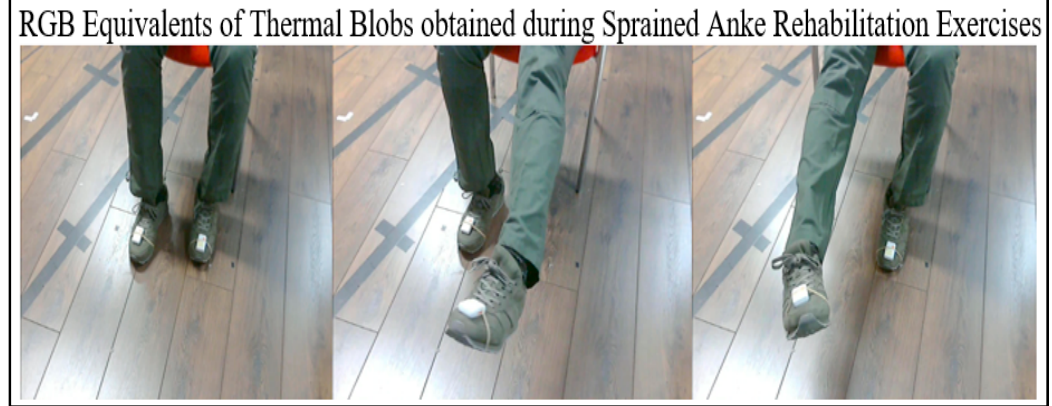
Figure 4. RGB equivalents of the thermal images recorded during sprained ankle rehabilitation exercise. A Shimmer-3 accelerometer is worn on metatarsals (on both legs) for ground-truth velocity measurements.